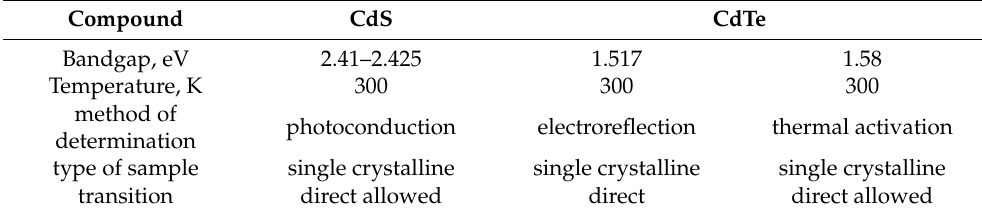
Figure 3. UV-Vis absorption spectra of PA 6, chalcogenized samples in the solutions of H 2 TeS 4 O 6 and samples with the layers of cadmium chalcogenides. Table 4. Bandgap values of CdS and CdTe compounds